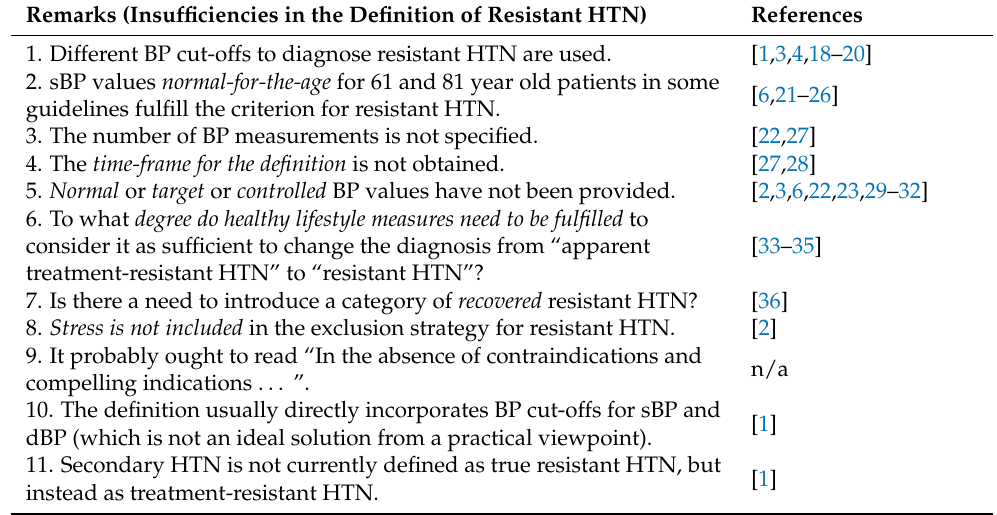
Table 1. Insufficiencies in the definition of resistant